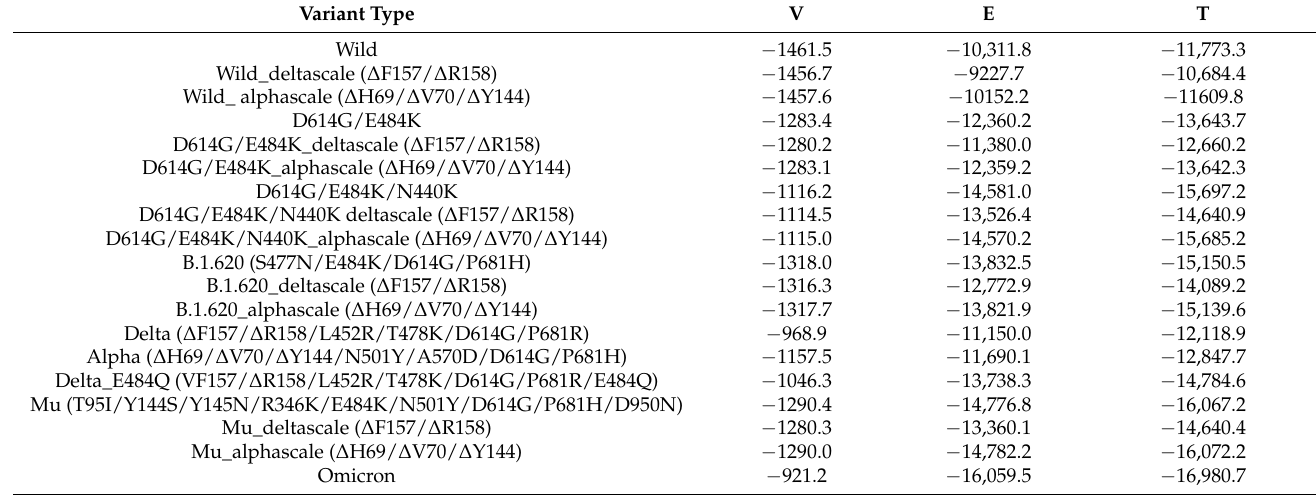
Figure 5. MM/PBSA results depending on the MD trajectories in the one-open-complex form (7A94) . ( a ) Wild type and ( b – i ) variants. ( b ) double, ( c ) triple, ( d ) B.1.620, ( e ) delta, ( f ) alpha, ( g ) delta_E484Q, ( h ) mu, and ( i ) omicron. The X axis denotes the trajectory (ps), and the Y axis denotes the MM/PBSA energy value (kJ/mol). Blue indicates the van der Waals energy between the S protein and ACE2, orange indicates electrostatic energy, and gray indicates the total energy. Table 2. Summary of the MM/PBSA between the S protein and ACE2 in the one-open-complex form. VdW indicates van der Waals energy, E denotes electrostatic energy, and T is the total energy (kJ/mol). The values were measured in the final trajectory (10